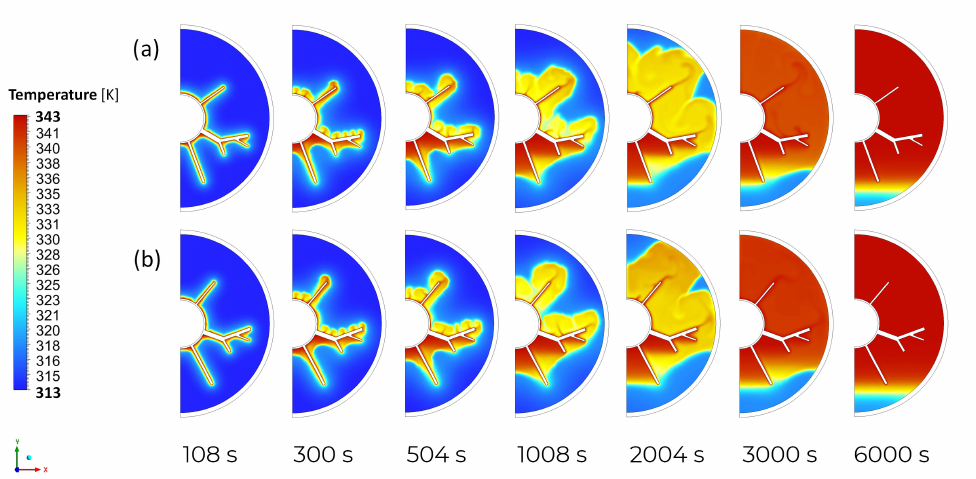
Figure 7. Temperature field during melting for ( a ) DP No. 4, ( b ) DP No.